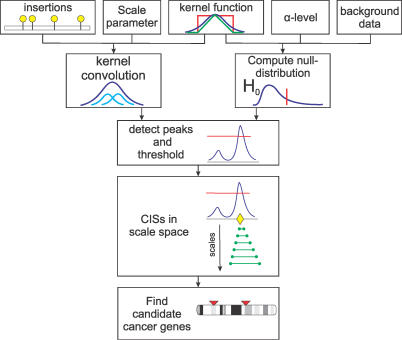
Schematic Depiction of the Kernel Convolution FrameworkThe insertions are convolved with a kernel function with a width determined by the scale parameter. In principle any kernel function can be used, but the Gaussian kernel function is depicted. The significance of the peaks is evaluated using a null-distribution computed by means of a random permutation of the data. This is done for a range of scale parameters to obtain the CISs in the scale space.